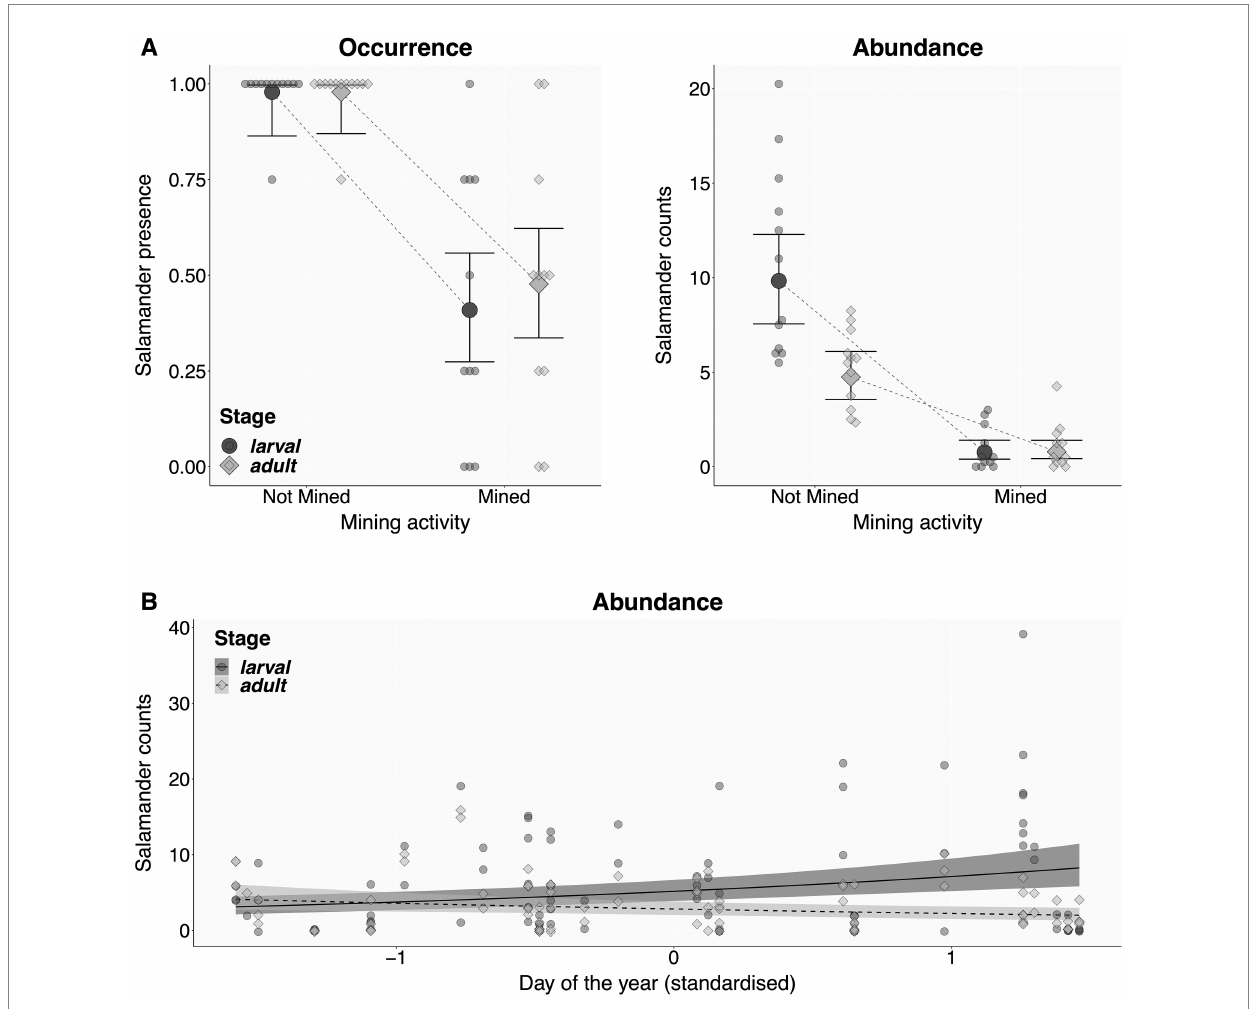
FIGURE 5 Salamander individual counts as a function of salamander stage and mining activity (A) , and salamander stage and day of the year (B) . Each point is an average value per combination of stage, site, and mining activity ( N = 23 sites, representing the true replicates), showing either the proportion of four repeated surveys with at least one individual present ( A : Occurrence), or the mean salamander count ( A,B : Abundances). Mean model predictions (filled markers or shades) and their 95% compatibility intervals (bold lines) were derived from 10,000 simulations of the posterior distribution of model parameters.